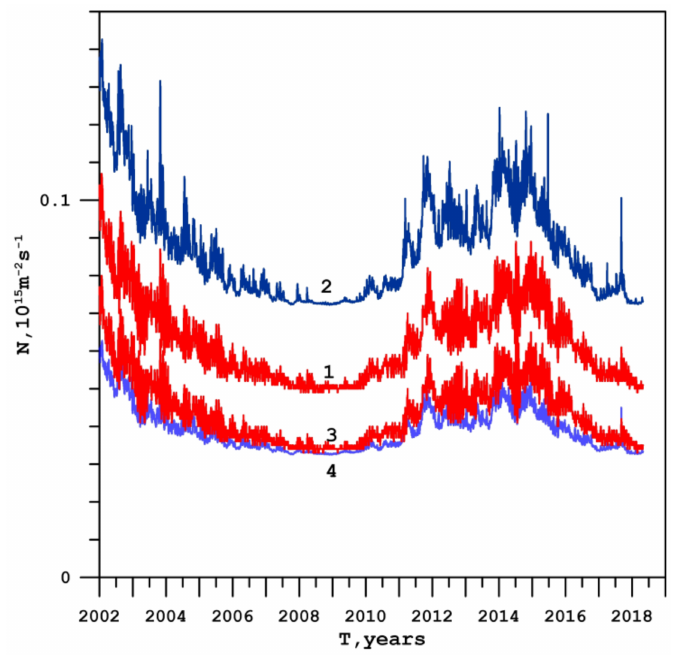
Figure 7. Time variations in the 23–24 activity cycles of individual lines of the EUV region. 1, 2—30.4 nm, 3. 4—102.6 nm. Blue lines—EUVAC, Red —EUVT. It can be seen that in line 30.4 EUVAC is always higher than EUVT (by ~30% on average). This fact will affect the modeling of the F-layer. On the contrary, for the 102.6 nm line, calculations by the EUVT model give an excess over EUVAC by an average of ~12%. This spectral line (along with the CIII 97.7 nm line) gives the main contribution to